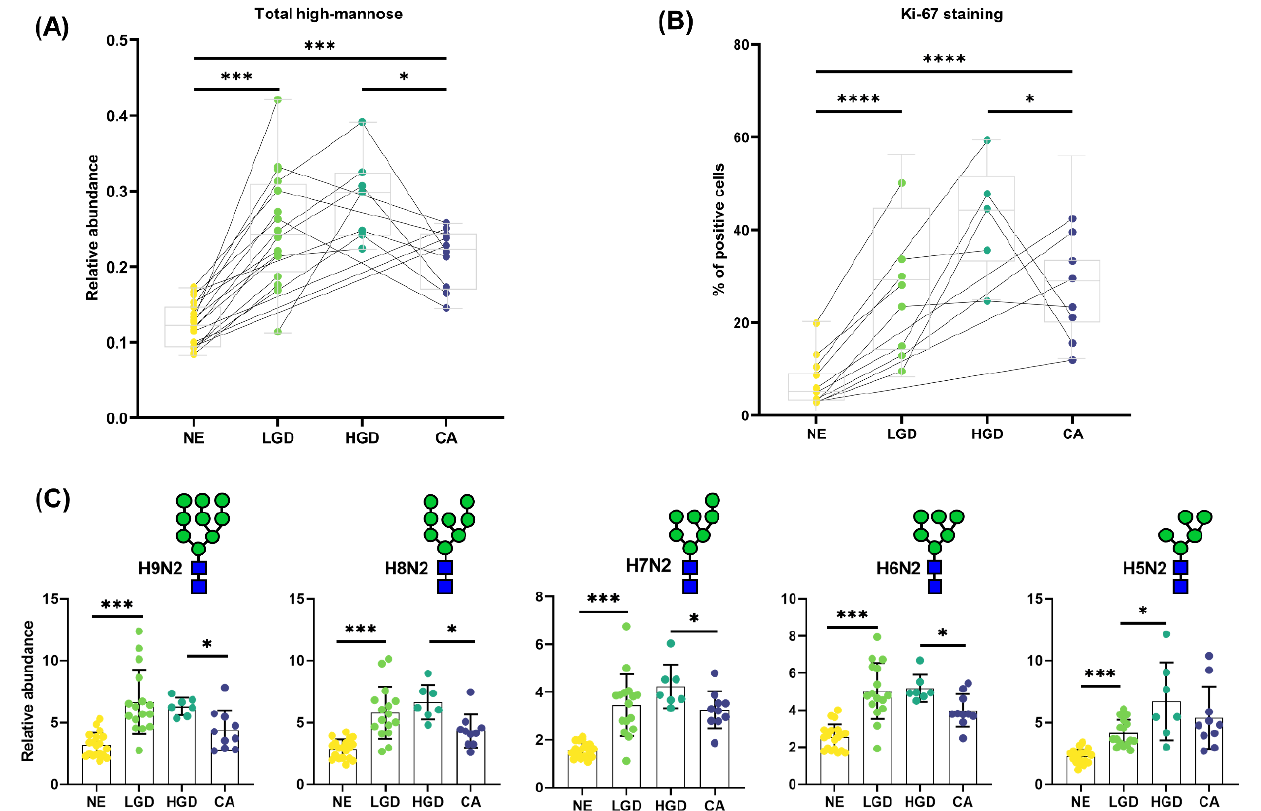
Figure 2. High-mannose N -glycans are abundant in proliferative cells. ( A ) The abundance of high- mannose-type N -glycans changes with progression through the morphological spectrum of T1 CRC development. ( B ) The changes in number of proliferative cells (Ki-67 + ) cells shows a similar pattern to the changes in high-mannose N -glycans. ( C ) All individual high-mannose-type N -glycans contribute and change in a similar fashion to the high-mannose trait depicted in ( A ). * = p -value ≤ 0.05, *** = p -value ≤ 0.001, **** = p -value ≤ 0.0001.